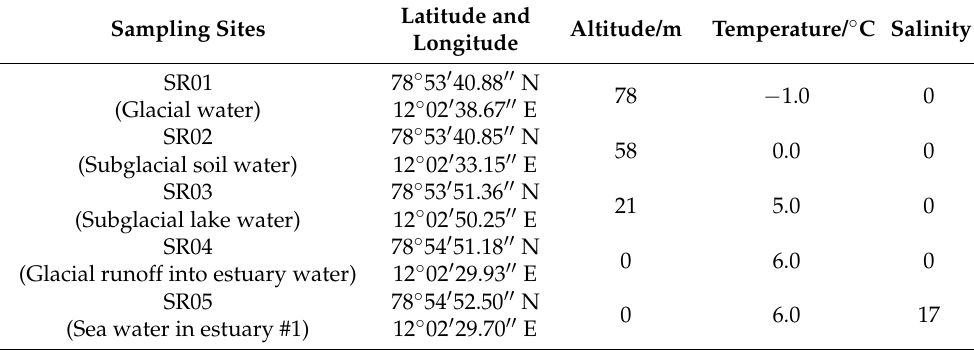
Table 1. Water sampling information at different